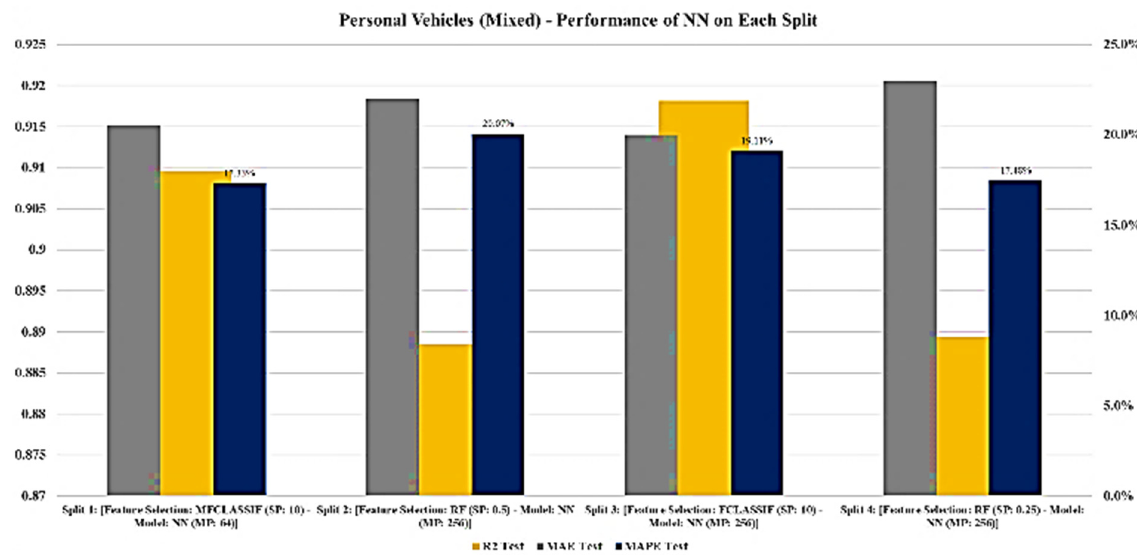
Figure 20. Performance of ANN model (with spatial variables) on the test data set for total PV.